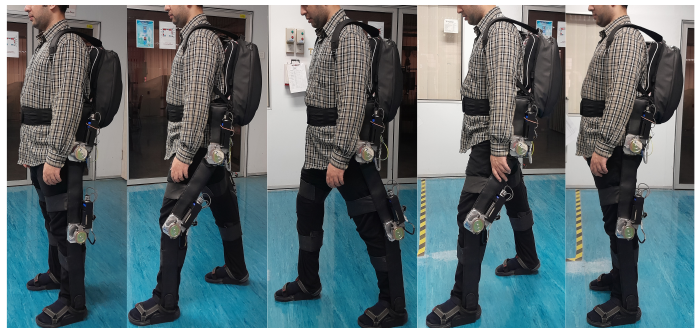
Figure 7. The walking snapshots of the subject wearing the wearable lower-limb rehabilitation ex- oskeleton.